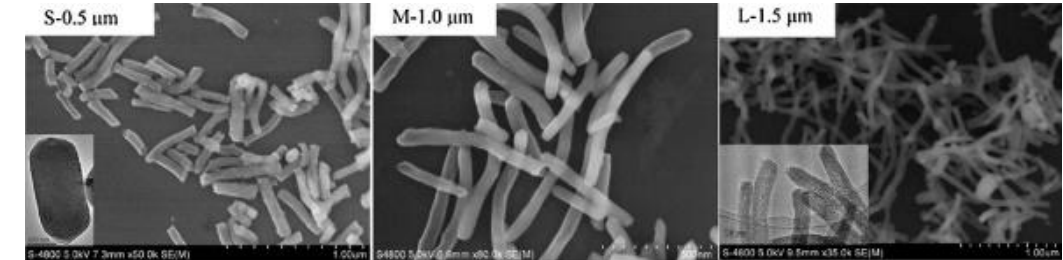
Figure 11. The controllable morphology of mesoporous silica nanotube. Reprinted from Ref. [104], Copyright 2015, with permission from Elsevier.